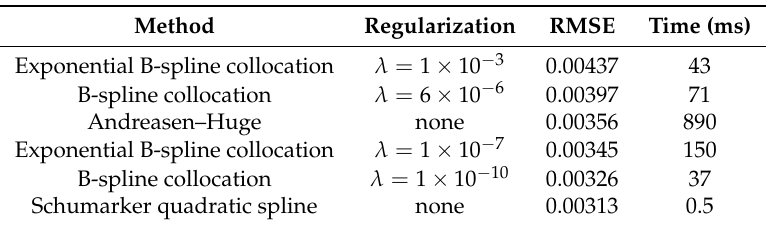
Table 1. Root mean square error (RMSE) of the collocation method implied volatilities against the market implied volatilities of the TSLA 1 m options as of 18 June